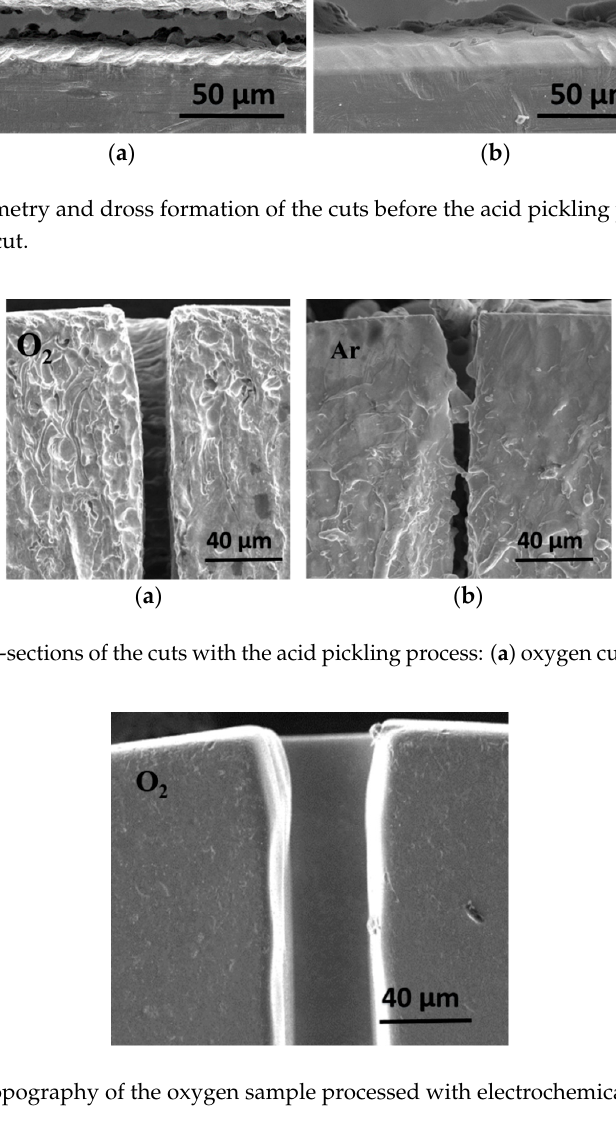
Figure 8. Topography of the oxygen sample processed with electrochemical polishing.